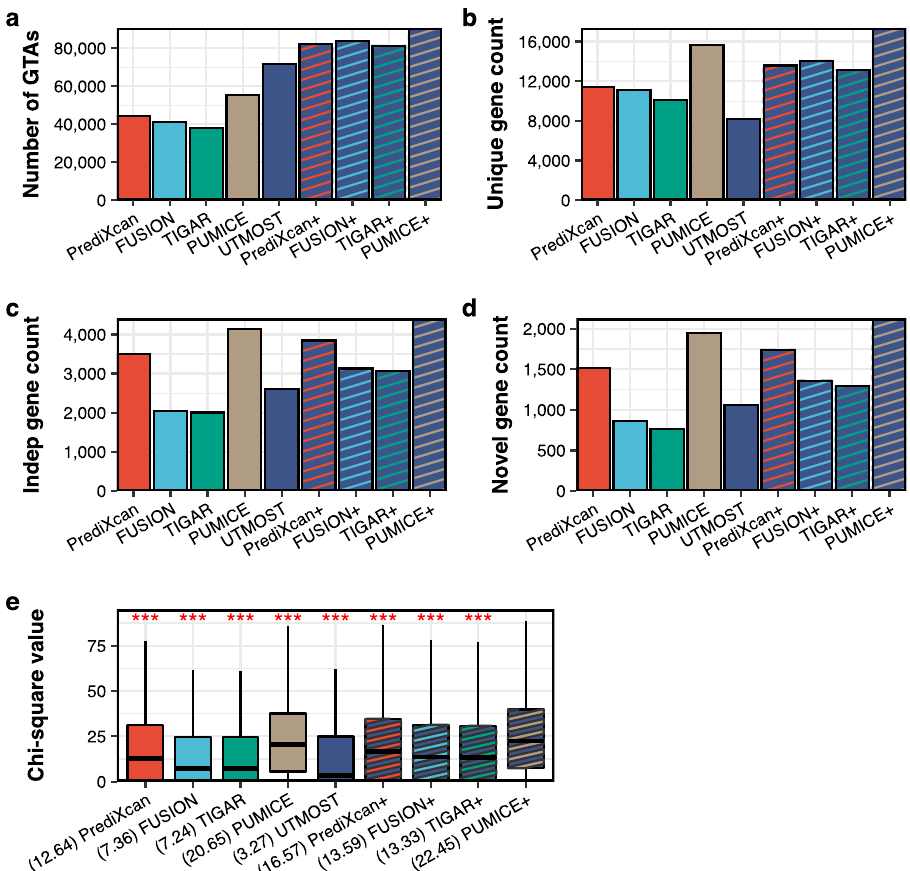
Fig. 5 PUMICE + identi fi es the largest number of gene x trait associations and novel associations across 48 GTEx tissues using GWAS summary-level statistics of 79 traits. Panel ( a ) displays the total number of signi fi cant gene x trait associations by each method. Panel ( b ) shows the number of unique signi fi cant gene x trait associations. Gene x trait associations identi fi ed in multiple tissues are counted only once. Panel ( c ) shows the number of independent gene counts. Multiple signi fi cant genes within 1 Mb window are counted only once. Panel ( d ) shows the number of independent novel genes that are outside 1 Mb window on either side of GWAS sentinel variant. PUMICE + identi fi es the highest number of gene x trait associations, unique gene count, independent gene count, and novel gene count in comparison to all other methods. Panel ( e ) displays the distribution of chi-square test statistics at MAGMA-prioritized genes. Median value is denoted in the parentheses. PUMICE + achieved the largest median value of chi-square values (22.45). P- value is based on the comparison between PUMICE + and other method using one-sided median test. *** denotes signi fi cant differences with p < 0.001. One- sided p- values are provided in the source data fi le. Each boxplot is derived from the chi-square values across 12,546 MAGMA-prioritized genes. Minima and maxima values (excluding outliers) are represented by the lower- and upper-bound of the whiskers. Median value is represented by the bold line in the middle. First and third quartiles are represented by the lower- and upper-bound of the